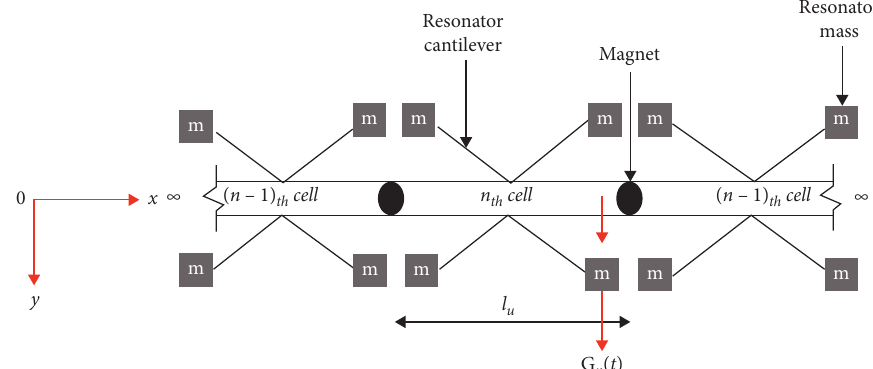
Figure 3: Cartoon model schematic of beam with local resonators representing the metamaterial vibration attenuation energy harvesting